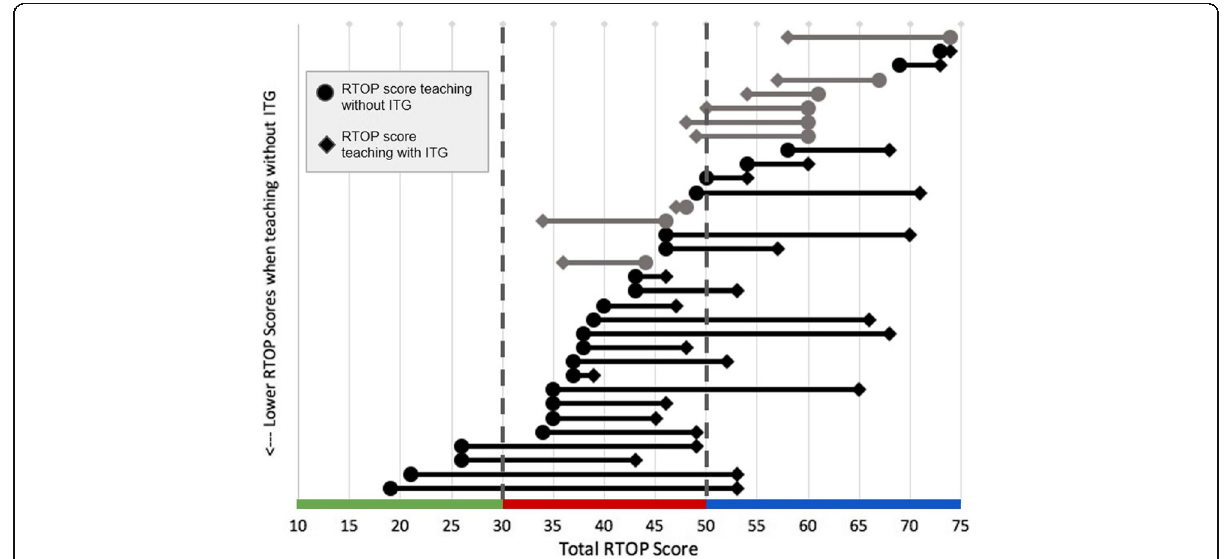
Fig. 7 Comparison of RTOP scores for individual instructors when teaching both with (diamond) and without (circle) ITG. Black lines connecting the two scores indicate RTOP scores when teaching with ITG were higher for that instructor; grey lines connecting the two scores indicate RTOP scores when teaching without ITG were higher for that instructor